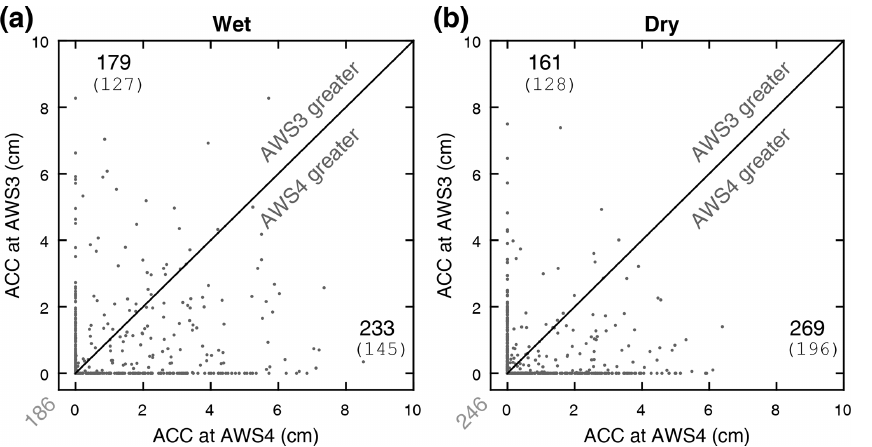
Figure 11. AWS3 versus AWS4 daily accumulation (ACC) during (a) the wet seasons and (b) the dry seasons between 8 October 2009 and 30 September 2013. Number of days when either AWS3 or AWS4 ACC was greater are displayed in the respective corners (numbers in parentheses are the contained cases when the other station recorded zero ACC). In grey below the lower-left corner of the plots is the number of days when ACC is zero at both stations.